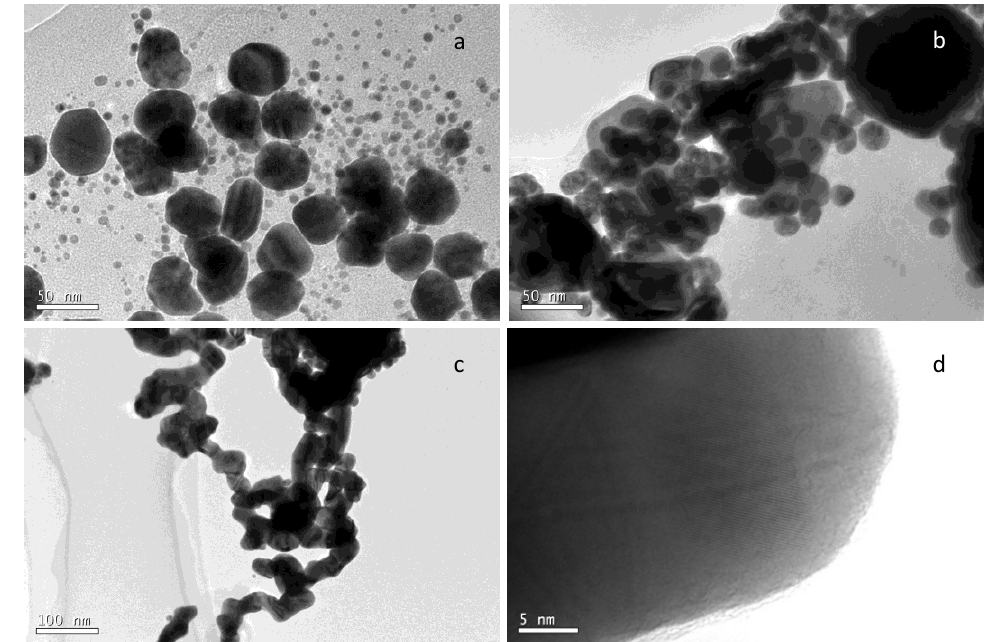
Figure 4. Effect of gold ions concentration. TEM images of gold nanoparticles obtained at pH 10 using different HAuCl 4 concentrations: ( a ) 100; ( b ) 250; and ( c ) 500 mg/L; ( d ) detail of nanostructure of the gold